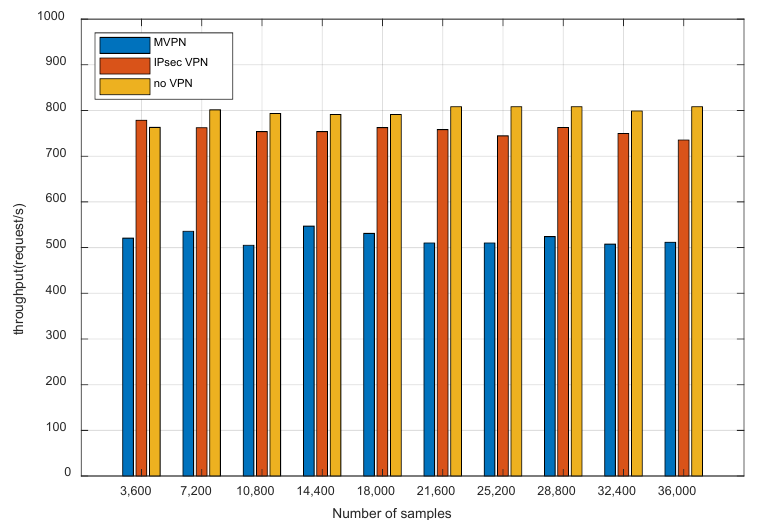
Figure 14. Throughput Test Results.